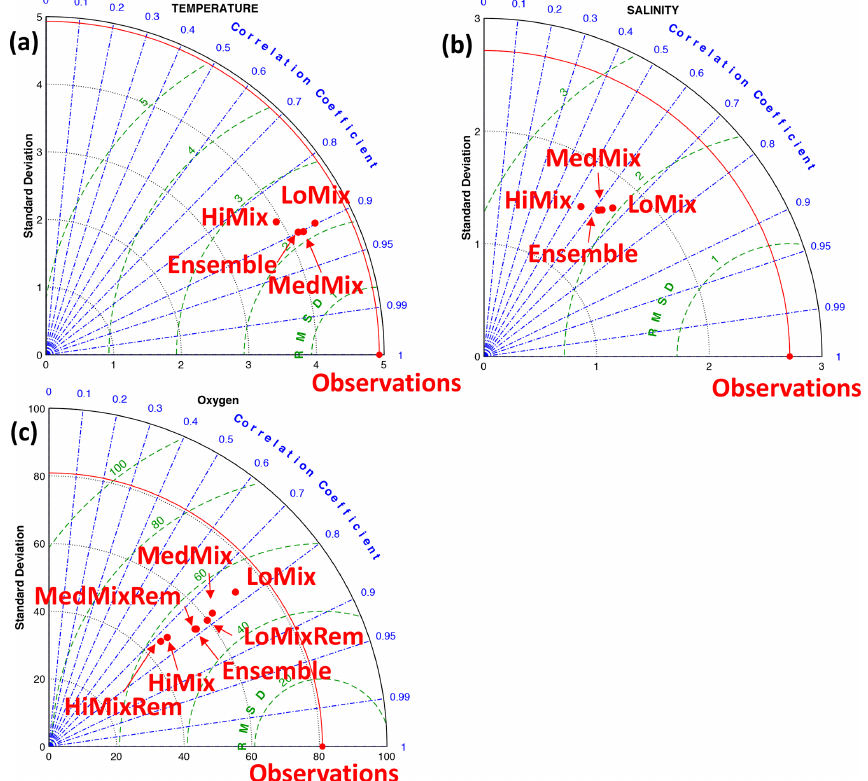
Figure 4. Model assessment (Taylor plots) at station Buoy 2a in the interior of EB (Fig. 2). Observational data and model output refer to the 2000 to 2015 period. The simulation tags are defined in Table 2: LoMix , MedMix , and HiMix denote the levels of diffusive background mixing. Rem indicates remote effects of biogeochemical sources and sinks of oxygen only (i.e., no local oxygen consumption in